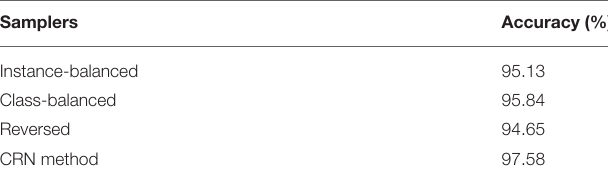
TABLE 3 | Dataset statistics.